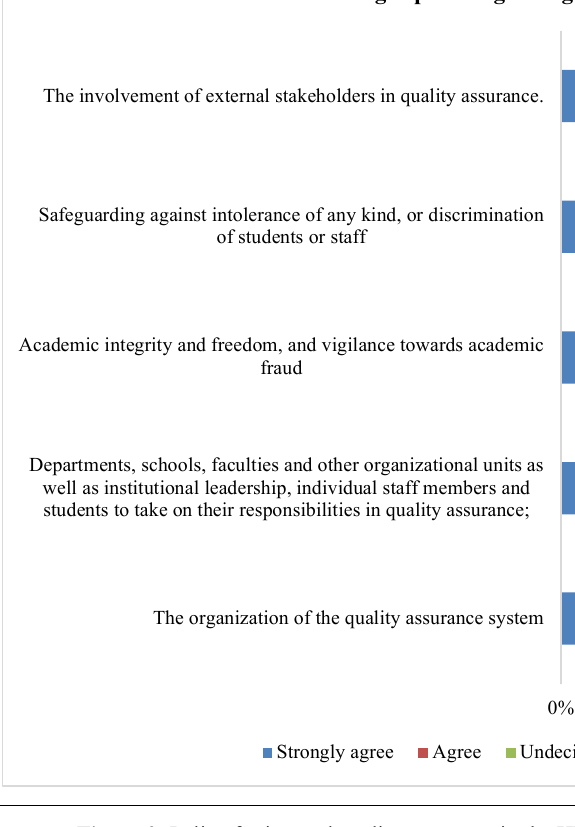
Figure 2 : Policy for internal quality assurance in the HEIs in Albania